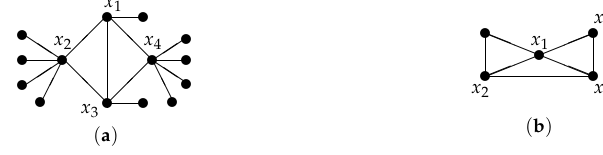
Figure 11. Two 3-cutwidth graphs containing τ 5